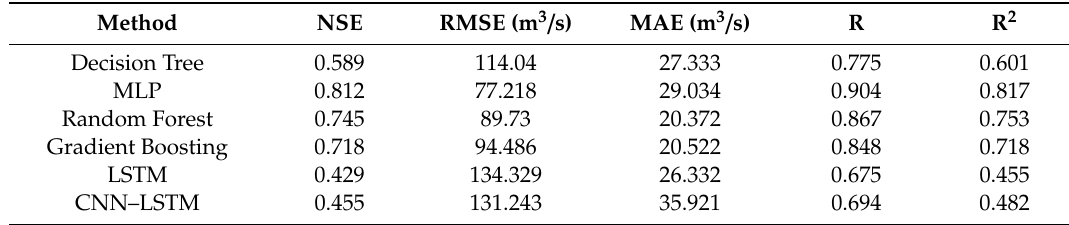
Table 4. Prediction accuracy results of six machine learning models.